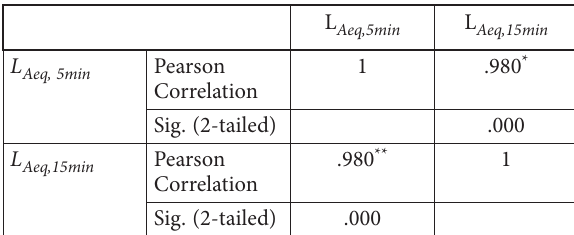
Table 1. Results of Pearson Correlation between L Aeq in 15 and 5-minute intervals